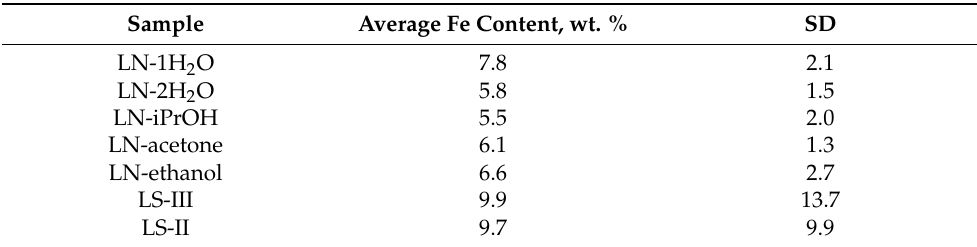
Table 1. Average values and standard deviations of the iron content on the surface of the impregnated